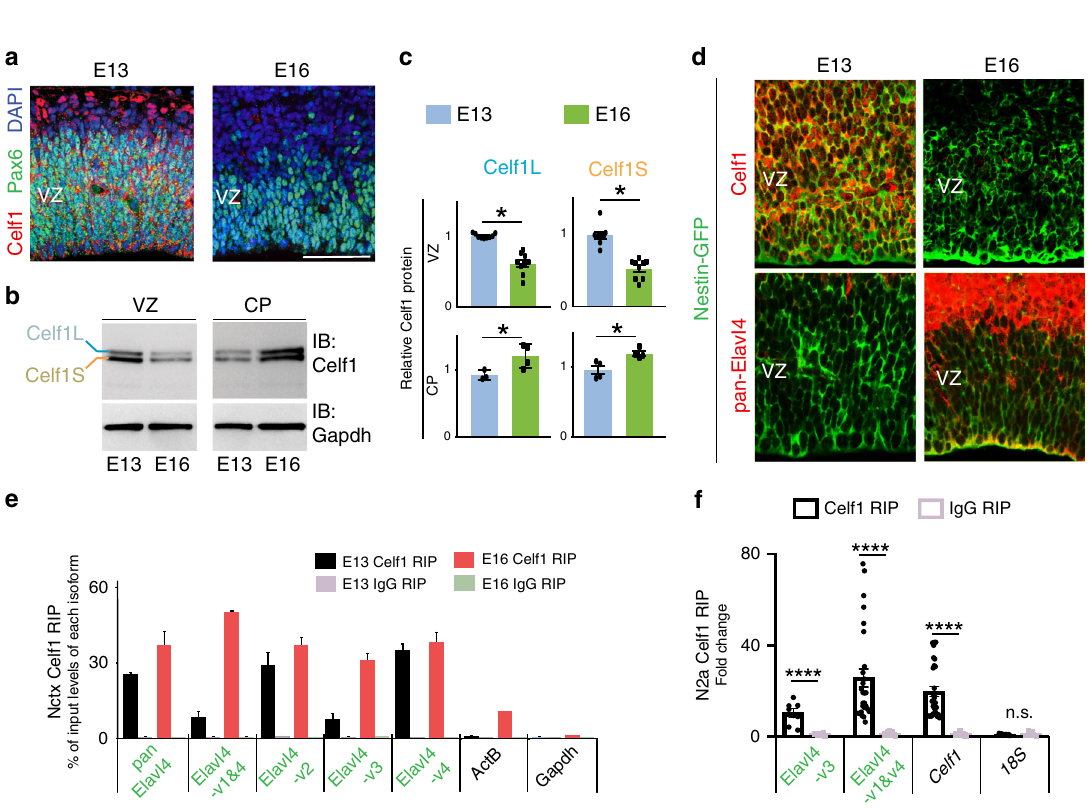
Fig. 3 Celf1 binds Elavl4 developing neocortices. a Celf1 (red) and Pax6 (green) VZ, IHC at E13 and E16 ( n = 3 animals per age). DAPI shown in blue. b Western blot of Celf1 protein (upper panel) expression in VZ and CP from LCM neocortices at E13 and E16 ( n = 3 animals per age). The Celf1 upper band is putatively Celf1 Long (Celf1L); the Celf1 lower band is putatively Celf1 Short (Celf1S), indicated at left. Gapdh was used as a loading control (bottom panel). c Densitometry quanti fi cation of b . Data represent the mean and SEM. Data normalized to Gapdh and then to E13. Statistics: Student ’ s t -test. * p < 0.05. d Celf1 (red, top) or Elavl4 (red, bottom) IHC on Nestin-GFP (green) neocortices at E13 and E16 ( n = 4 animals per age). e RNA immunoprecipitation (RIP) from E13 and E16 neocortices. Relative mRNA levels were determined by qRT-PCR from Celf1 vs. IgG RIPs ( n = 4 separate RIPs, 6 neocortices per age). Pan-Elavl4 and speci fi c Elavl4 isoforms are shown in addition to ActB and Gapdh as non ‐ binding controls. f RIP from N2a cells ( n = 3 RIPs from separate transfections). Data represent the mean and SEM. Data normalized to Gapdh . Celf1 was used as positive control 60 . 18S was used as